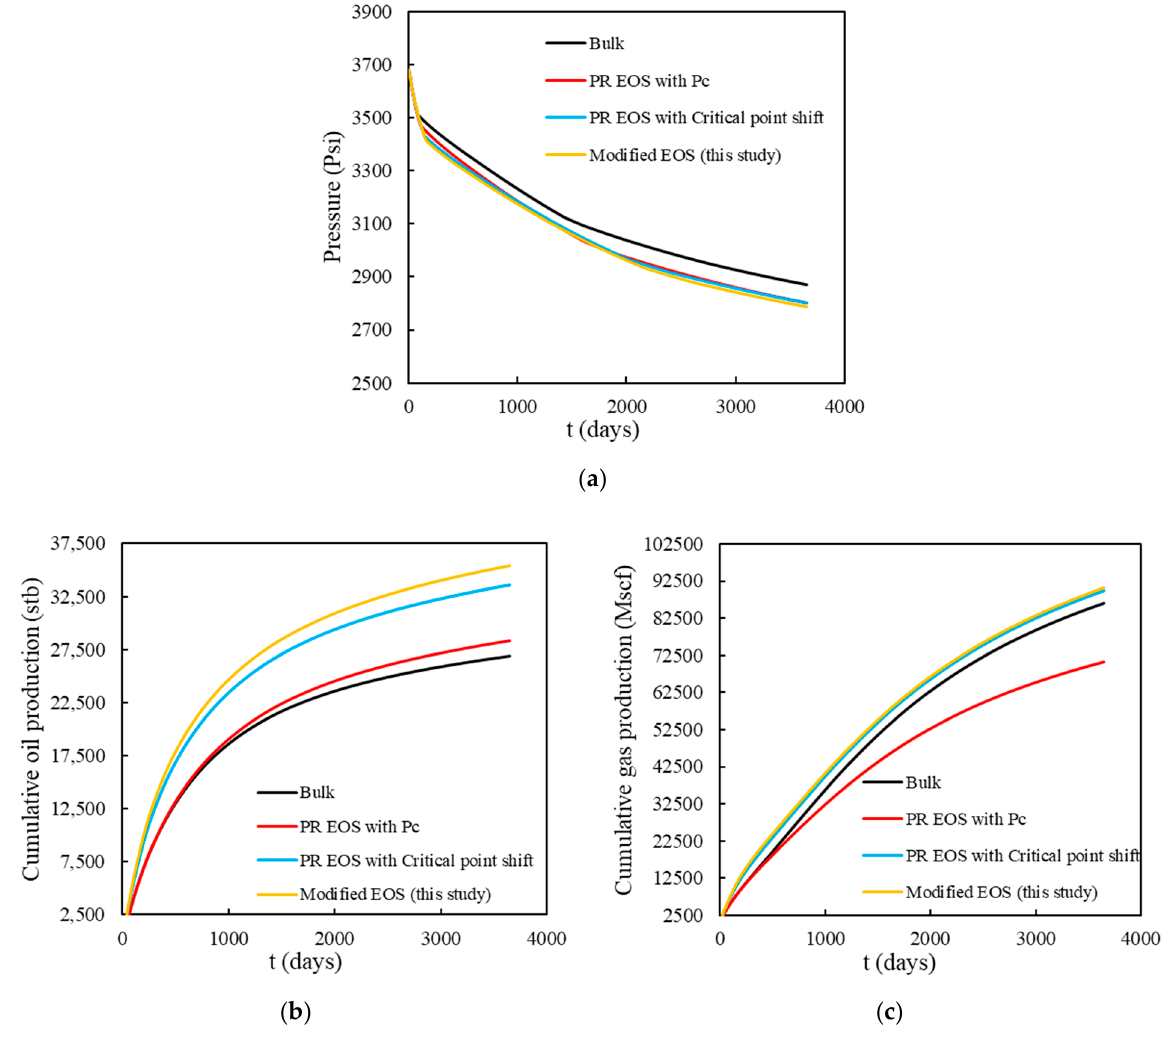
Figure 13. Comparison of reservoir performance from compositional simulation using methods of capillary pressure, critical shift, and modified EOS; ( a ) reservoir pressure, ( b ) cumulative oil production, and ( c ) cumulative gas production.